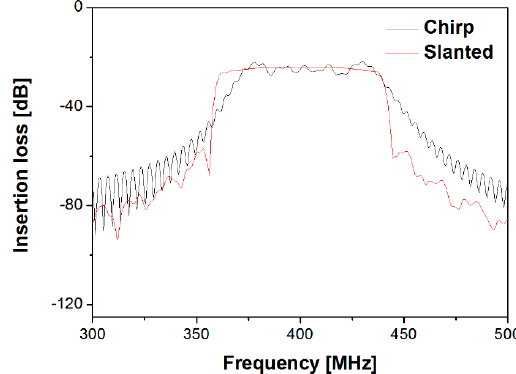
Figure 4. Passband responses of the slanted and chirp IDTs with respect to frequencies obtained from COM